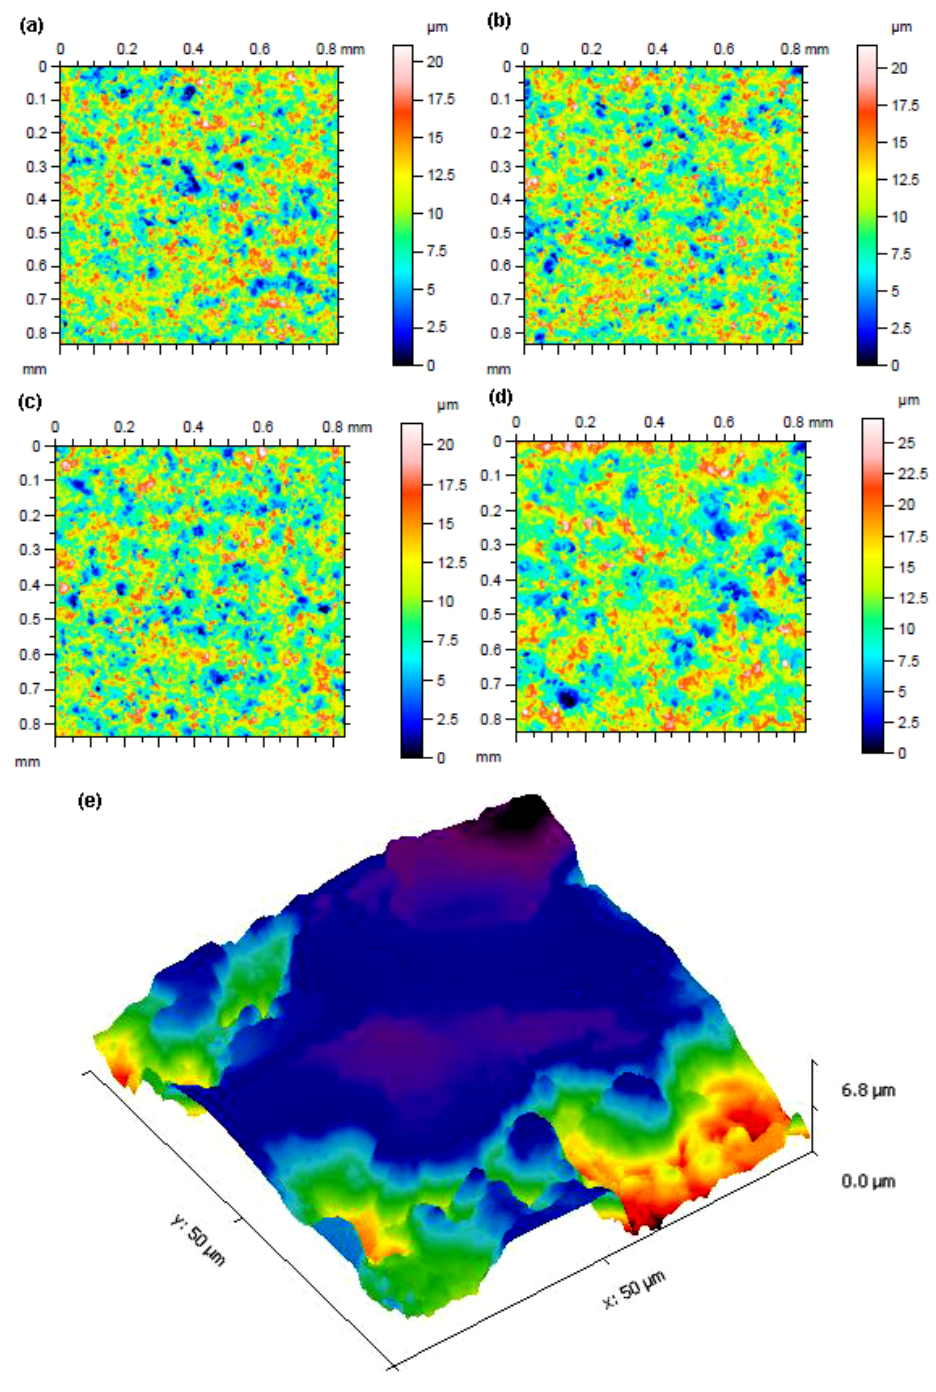
Figure 5. ( a )2D colour ‐ filtered relief of Sample surface 20, ( b ) 2D colour ‐ filtered relief of Sample surface 21, ( c ) 2D colour ‐ filtered relief of Sample surface 33, ( d ) 2D colour ‐ filtered relief of